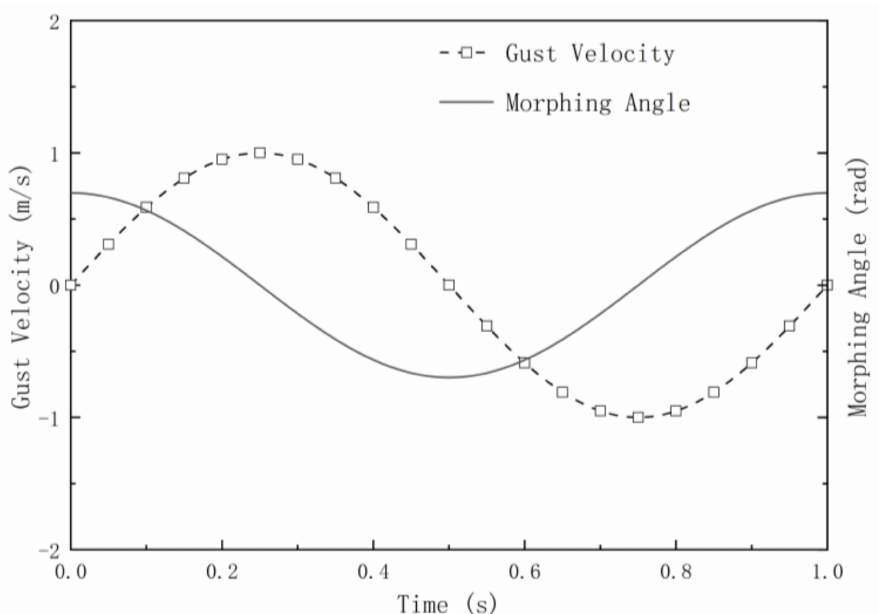
Figure 4. Curves of morphing angle and gust